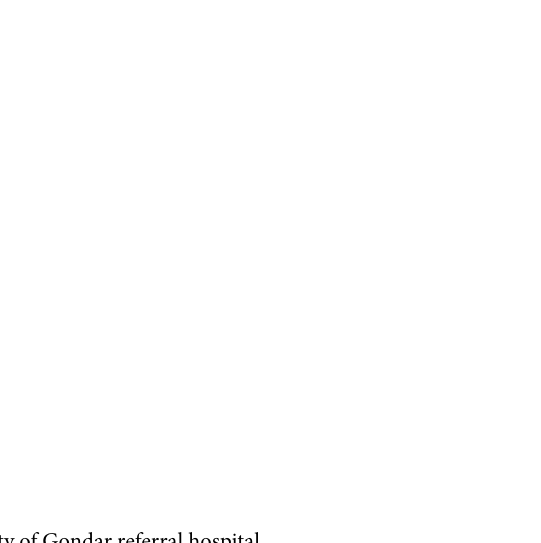
Table 3. Seizure related factors (n = 260), University of Gondar referral